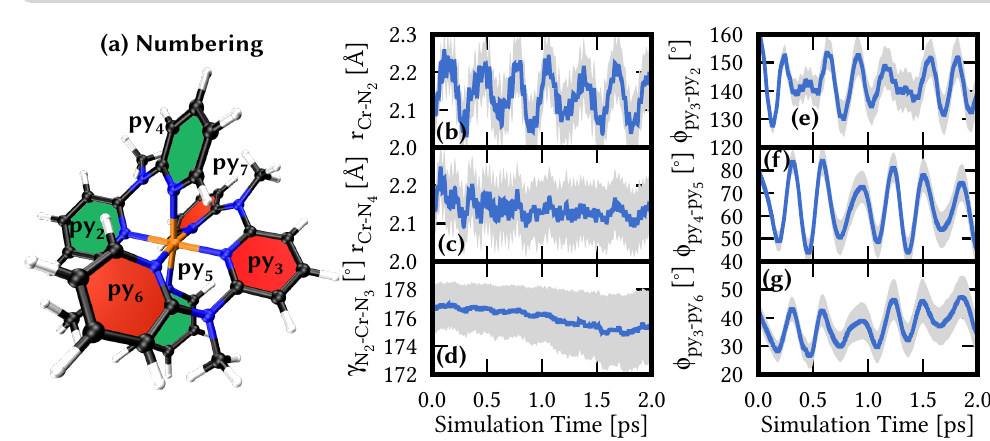
Figure 5. ( a ) Numbering of pyridine rings, which also corresponds to the numbering of N atoms. ( b – g ) Time evolution of selected internal nuclear coordinates along the simulation. Blue line denotes the average of the coordinates of 1000 trajectories, while gray areas denote the areas of standard deviation. ( b / c ) Cr–N bonding distances r . ( d ) N 2 –Cr–N 3 angle γ . ( e – g ) Angle φ between the Cr–N averaged planes through the atoms of the pyridine rings. Additional bond lengths and angles are presented in Section